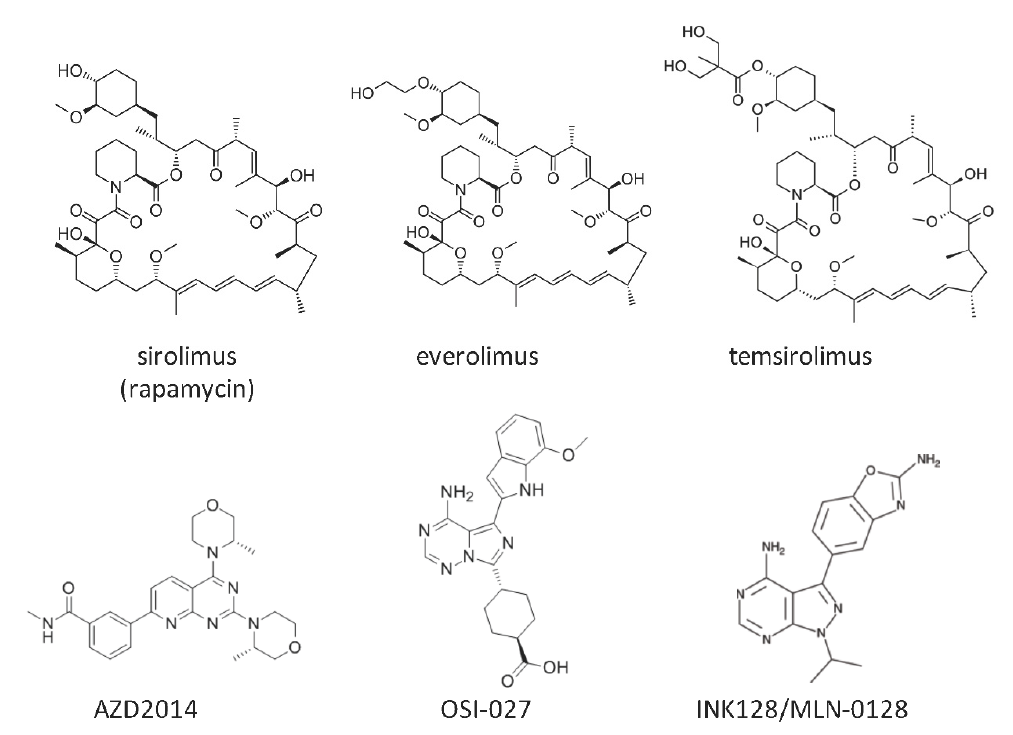
Figure 1. Chemical structures of mammalian target of rapamycin (mTOR) inhibitors.